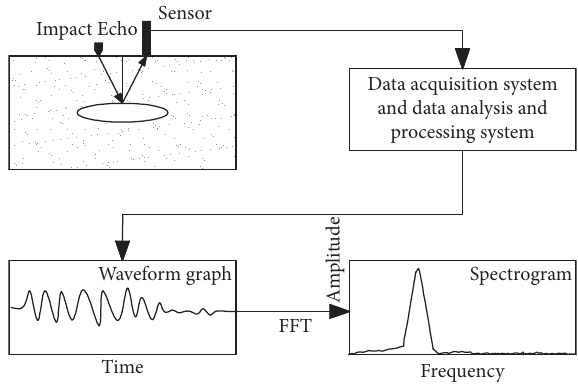
Figure 1: Schematic diagram of the shock-echo